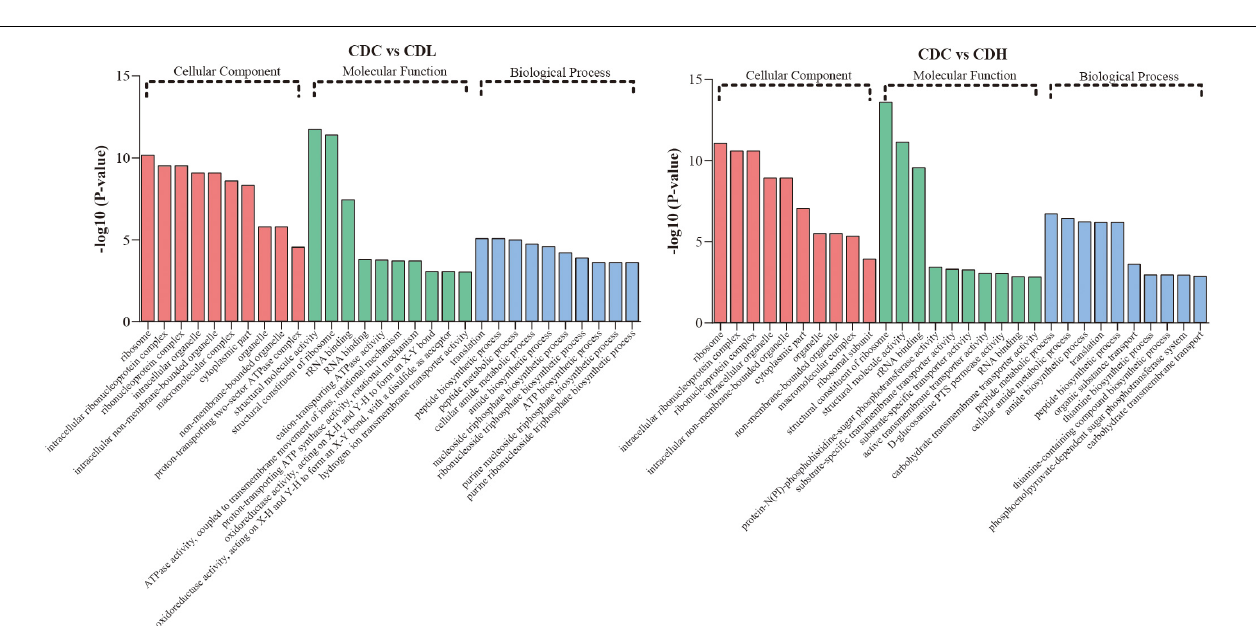
FIGURE 5 | GO term analysis of C. difficile DEGs in different groups. Top 10 GO terms belonged to cellular component, molecular component, and biological process were, respectively, included in CDL and CDH ( P -value < 0.05 was the significance threshold).